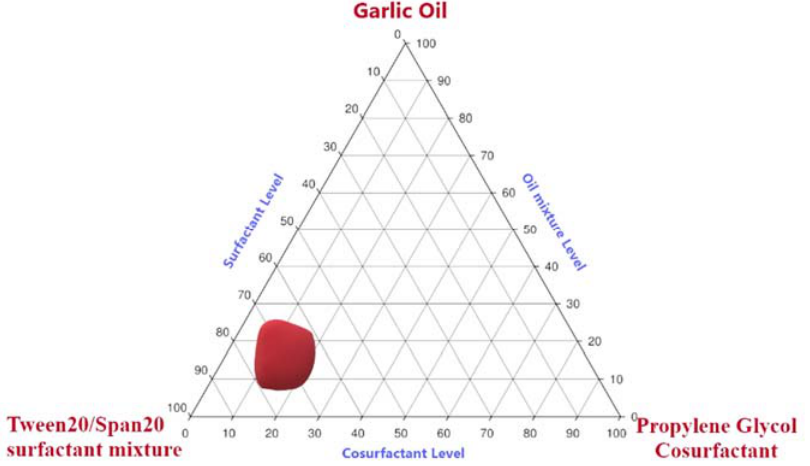
Figure 2. Pseudo ternary-phase diagram of selected components dispersed in water at 25 °C. Highlighted area represents the nanoemulsion region.